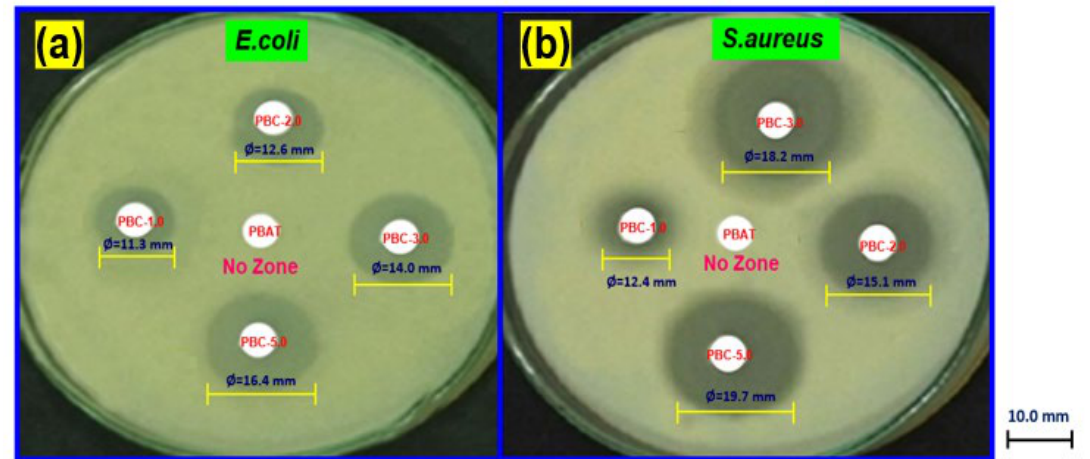
Figure 6. Antimicrobial properties of PBAT/kaolin clay composites with different wt% of kaolin; ( a ) E. coli , and ( b ) S. aureus .